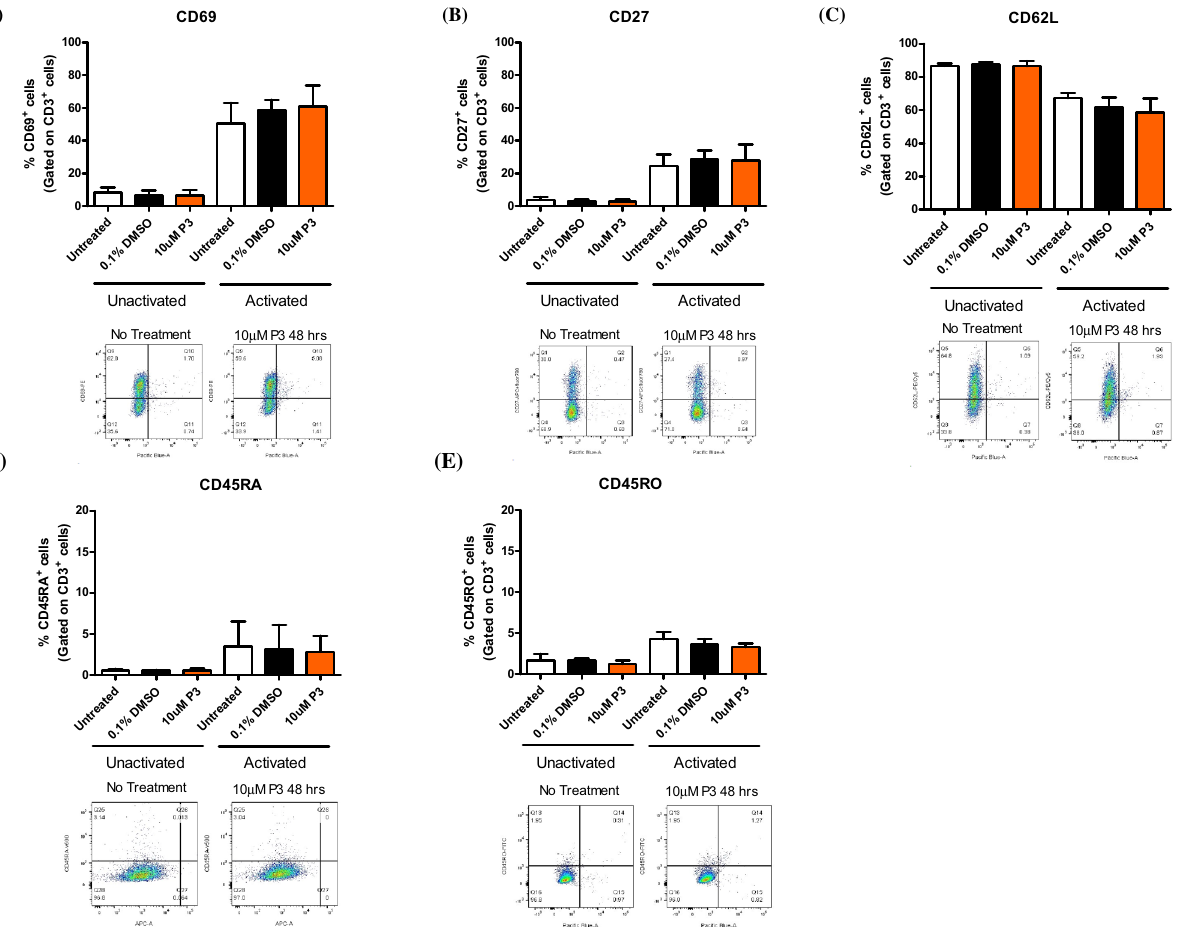
Figure 9. Pyrazinib (P3) does not significantly alter T cell activation marker expression. The effect of Pyrazinib (P3) on Jurkat cell activation marker expression was assessed by flow cytometry. The expression of ( A ) CD69, ( B ) CD27, ( C ) CD62L, ( D ) CD45RA and ( E ) CD45RO on Jurkat cells following treatment with media only, 0.1% DMSO control or 10 µM Pyrazinib (P3), (n = 3). Jurkat cells were activated with anti-CD3/CD28 antibodies. Statistical analysis was carried out using paired